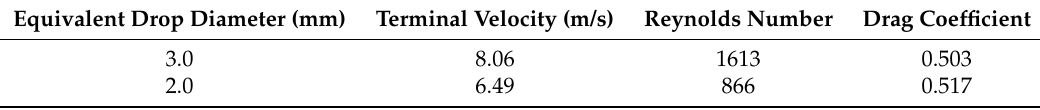
Table 2. Terminal velocities, corresponding Reynolds numbers and drag coefficients for 3 mm